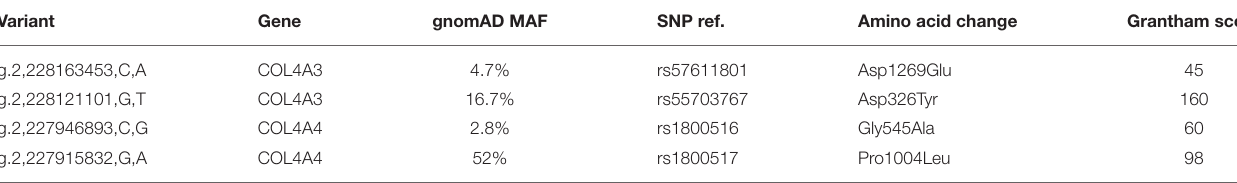
TABLE 1 | Missense variants in genes encoding collagen IV chains. Variant Gene gnomAD MAF SNP ref.